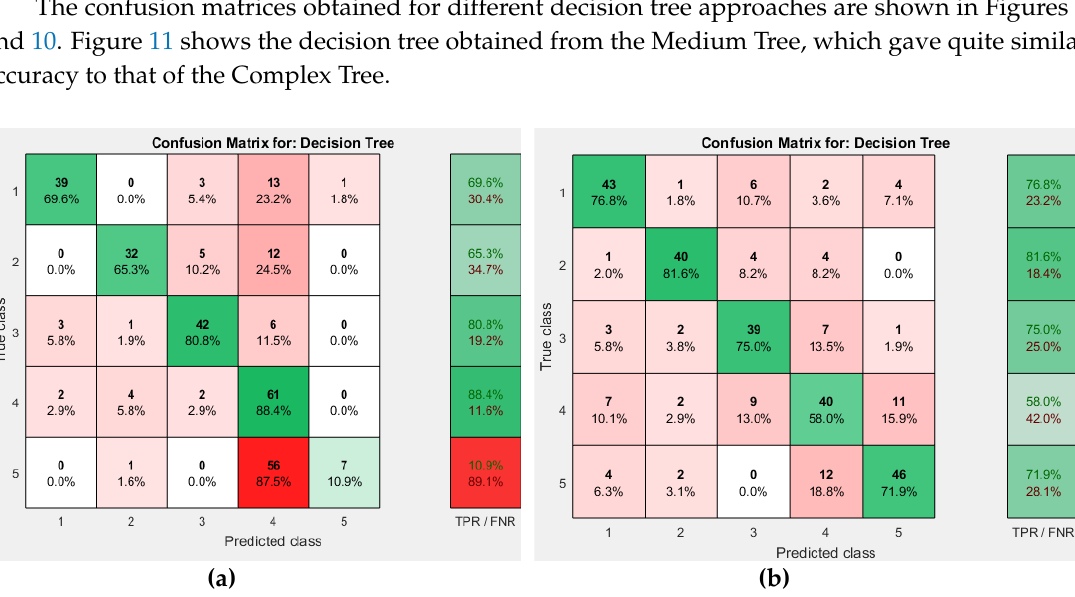
Figure 8. Cosine KNN Confusion Matrix.